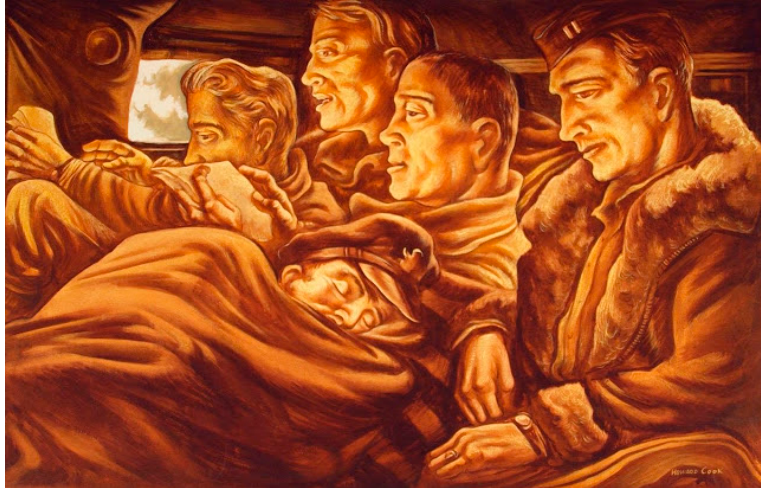
Figure 10. Howard Cook, The Ship Bombers’ Homecoming , 1943–1944, tempera, ink on illustration board. Permanent Collection of the Roswell Museum and Art Center, Gift of the Artist, 1973.031.0242. Used with permission.